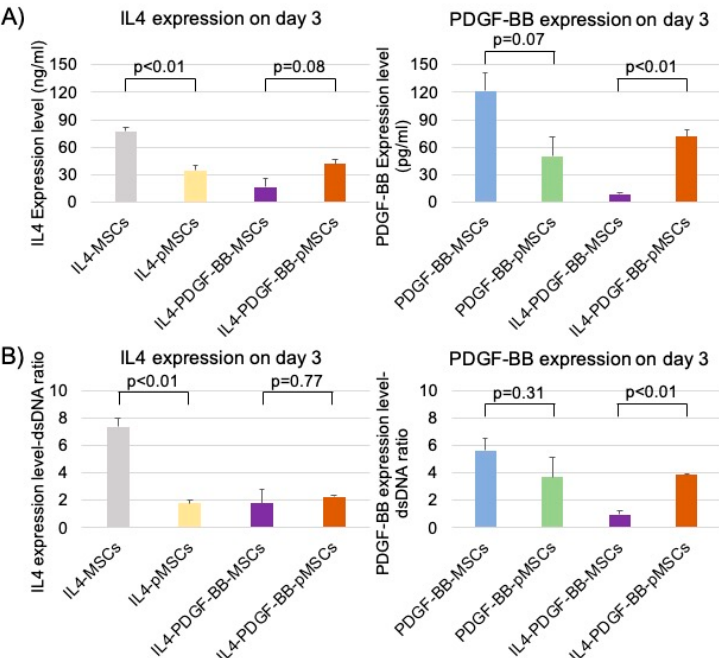
Figure 4. ( A ) IL4 and PDGF-BB expression levels on day 3 in the IL4-MSC, IL4-pMSC, PDGF-BB-MSC, PDGF-BB-pMSC, IL4-PDGF-BB-MSC, and IL4-PDGF-BB-pMSC groups. IL4 expression levels